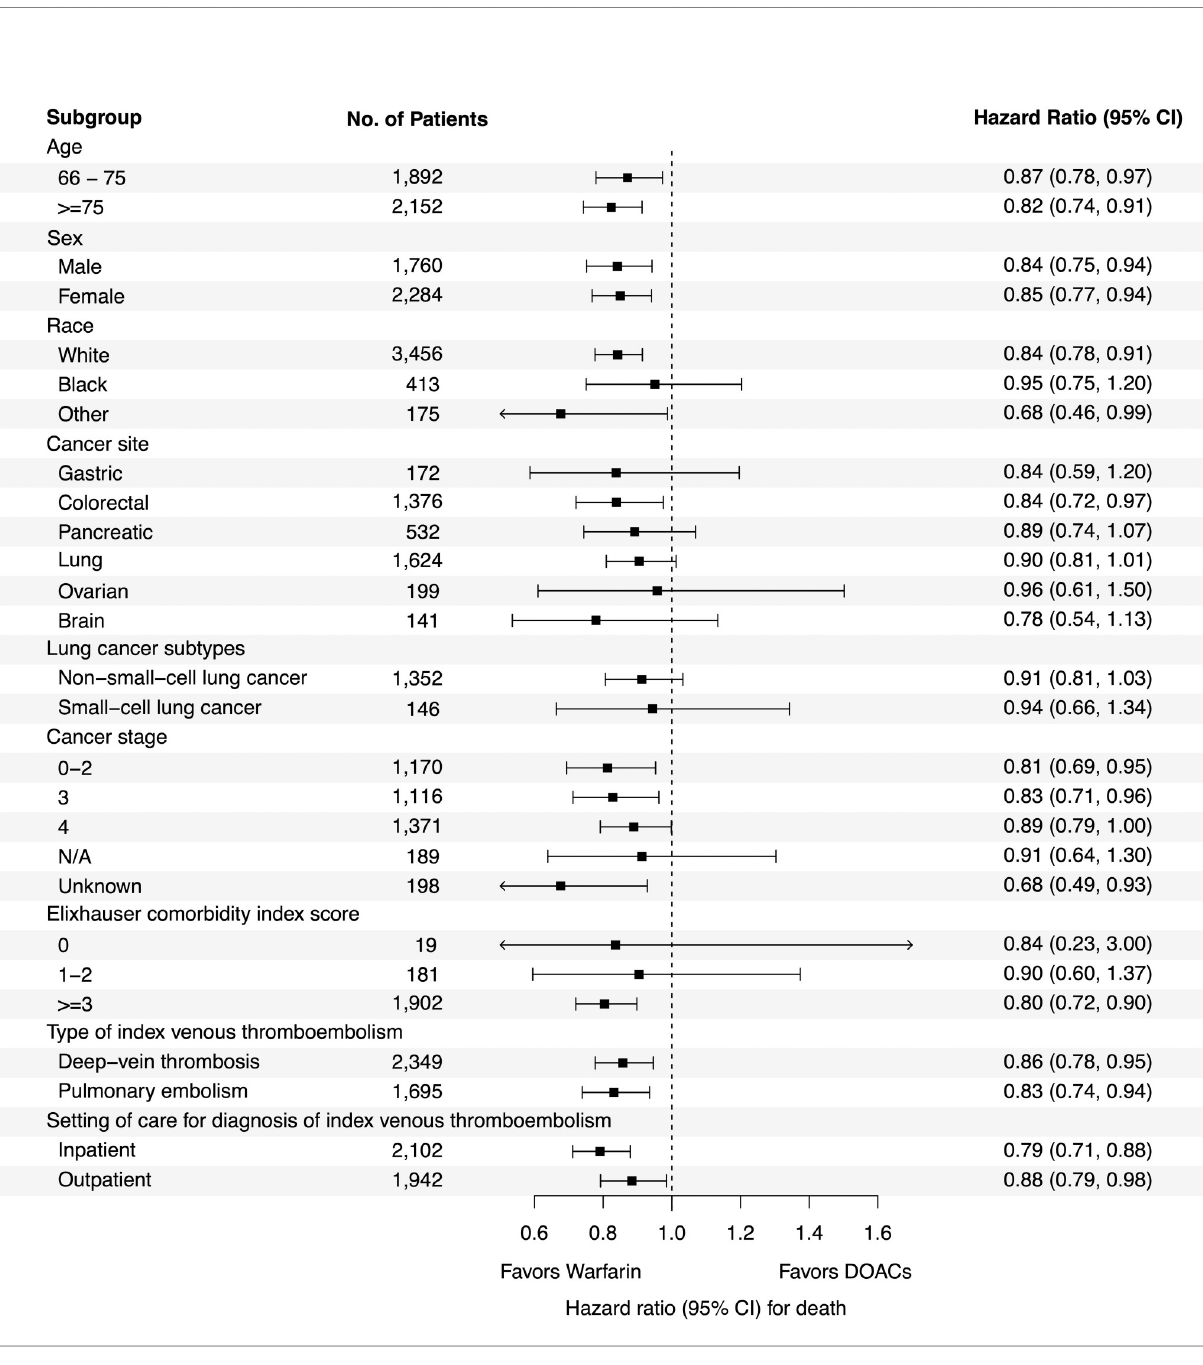
Fig 3. Forest plot of overall survival for subgroup analyses using a multivariable Cox proportional hazards model that included the anticoagulant group, the subgroup covariate of interest, and the subgroup-by-treatment interaction. CI, confidence interval; DOAC, direct oral anticoagulant. death was 12.4% among 390 patients with cancer randomized to edoxaban 60 mg daily com- pared with 11.5% among 395 patients randomized to warfarin (HR 1.09, 95% CI: 1.09 to 1.41) [34]. Confounding potential antineoplastic mortality signal in these atrial fibrillation trials was